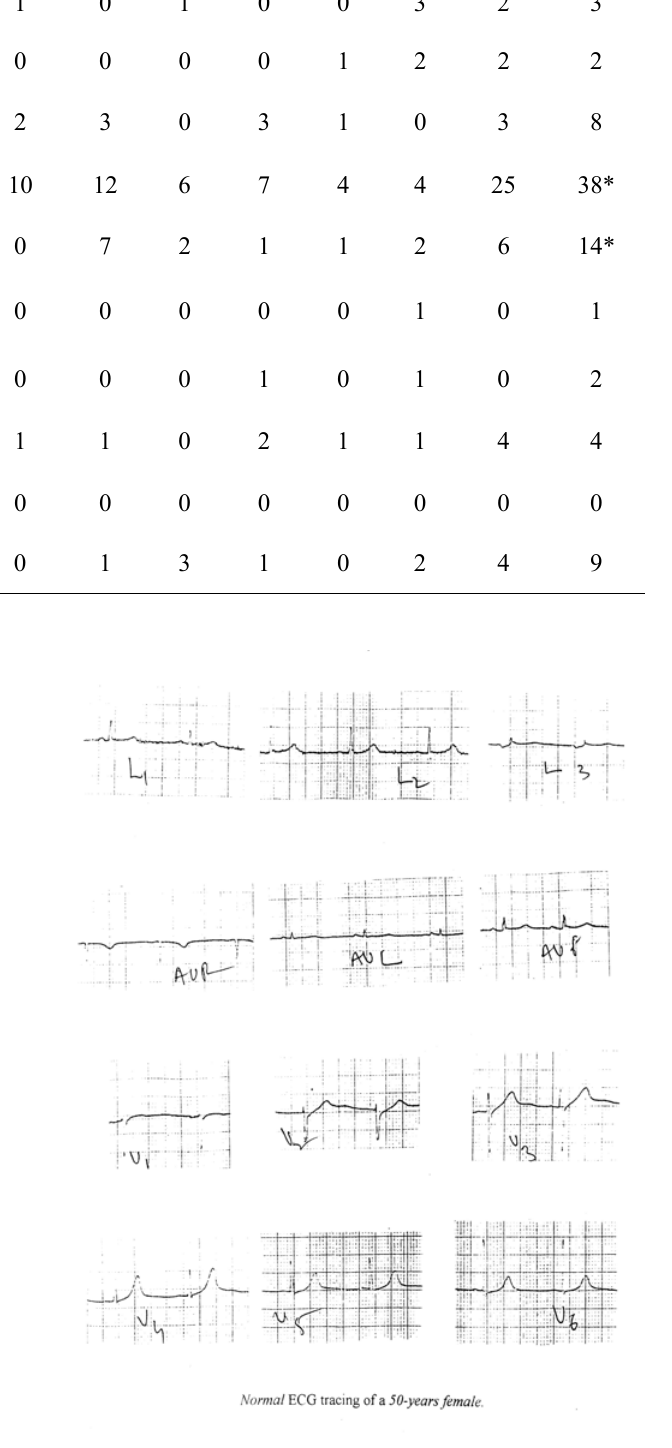
Figure 4a : A normal ECG tracing from the study